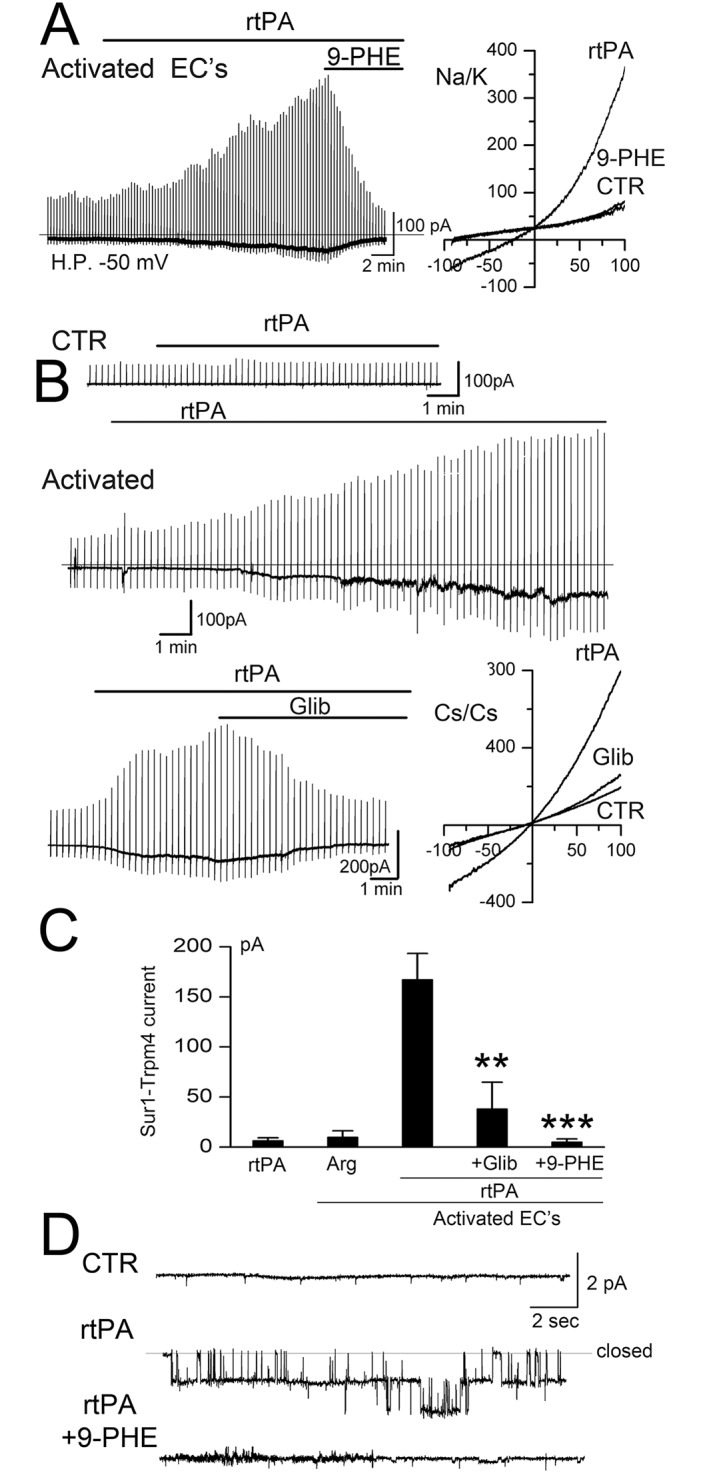
rtPA opens SUR1-TRPM4 channels.A–C: Macroscopic currents induced by recombinant tPA (rtPA) in activated murine BEC, recorded using physiological solutions (A) and using solutions with Cs+ as the charge carrier to block KATP (B); note that rtPA-induced currents could be slowly developing and long-lasting (A,B); currents in activated BEC were blocked by glibenclamide (Glib) and 9-phenanthrol (9-PHE); currents were not induced by rtPA in non-activated (CTR) cells or, in activated BEC, by L-arginine (Arg) (C); cells/condition for each bar: 16, 14, 25, 9, 5; **, P<0.01; ***, P<0.001. D: Single channel current, ~20 pS, in a cell-attached patch with two single channel levels before (CTR), after bath application of rtPA outside of the pipette (rtPA), and after addition of the cell-permeable TRPM4 antagonist, 9-phenanthrol (rtPA+9-PHE); holding potential, –70 mV; representative of 5 patches.